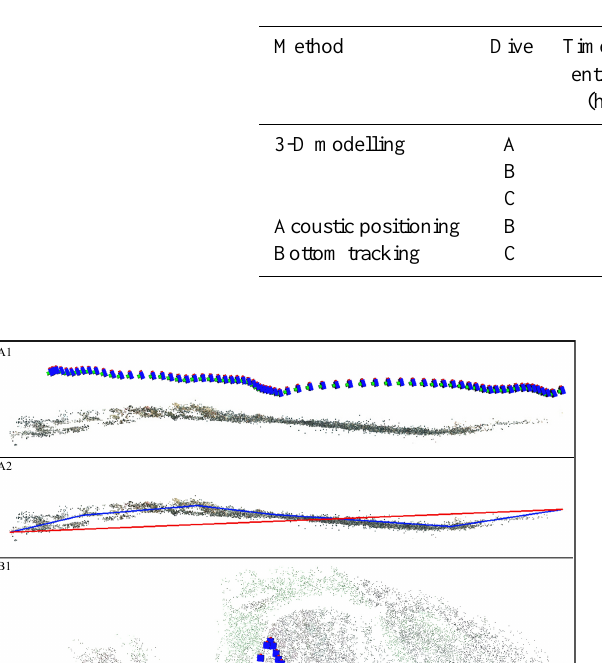
Table 3. Computing time necessary to obtain subtransect length with the three different methods.